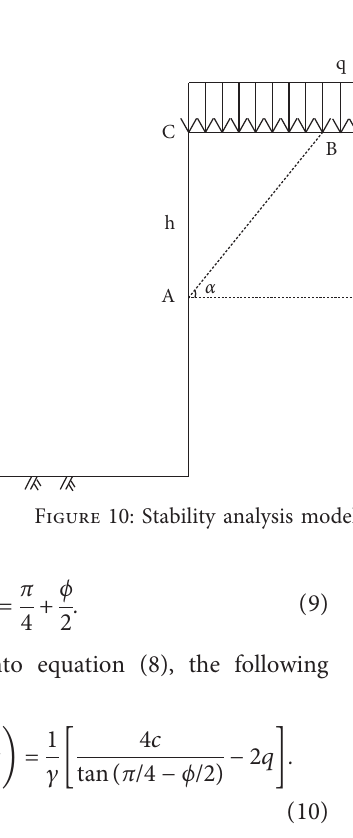
Figure 9: Variation curve of the foundation pit Hr